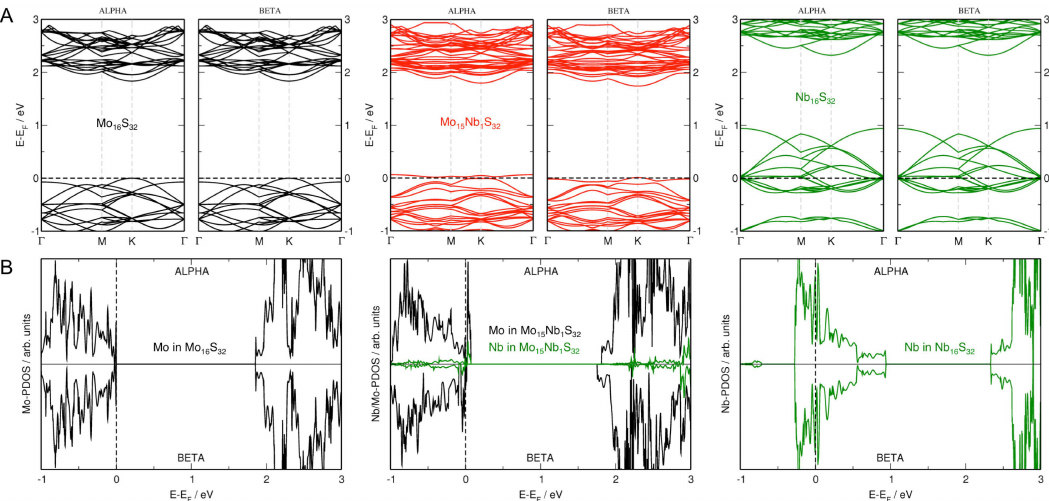
Figure 8. Spin-polarized electronic band structure ( A ) and density of states ( B ) of MoS 2 , NbS 2 and Mo 0.9275 Nb 0.0625 S 2 systems. The projection of states is shown on metal atoms. The Fermi level is indicated by the dashed horizontal line. No spin-orbit coupling is taken into